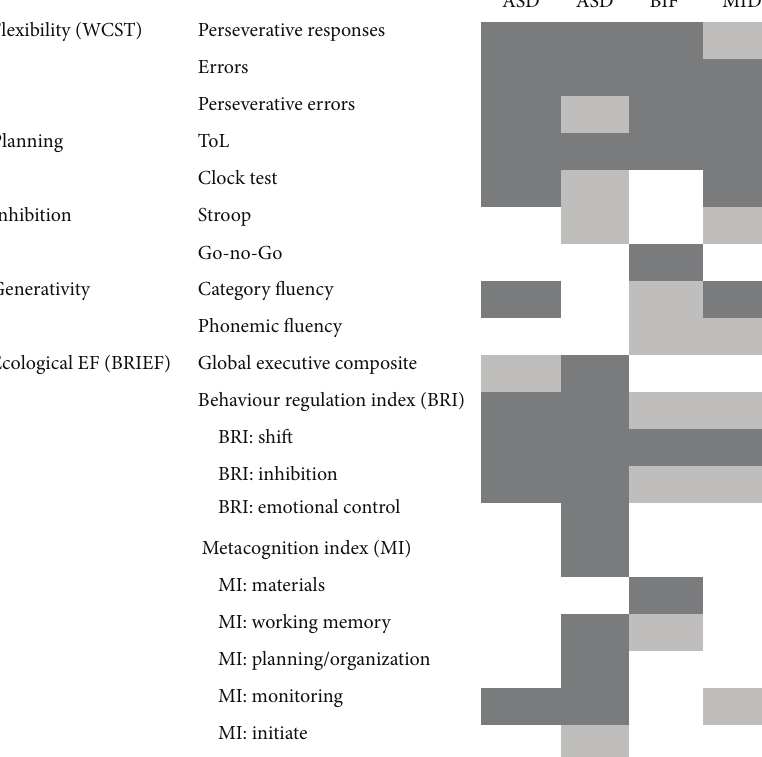
Figure 1: Graphic representation of EF impairments in ASD obtained in the study (dark grey: statistically significant impairment; light grey: nonsignificant impairment but large effect